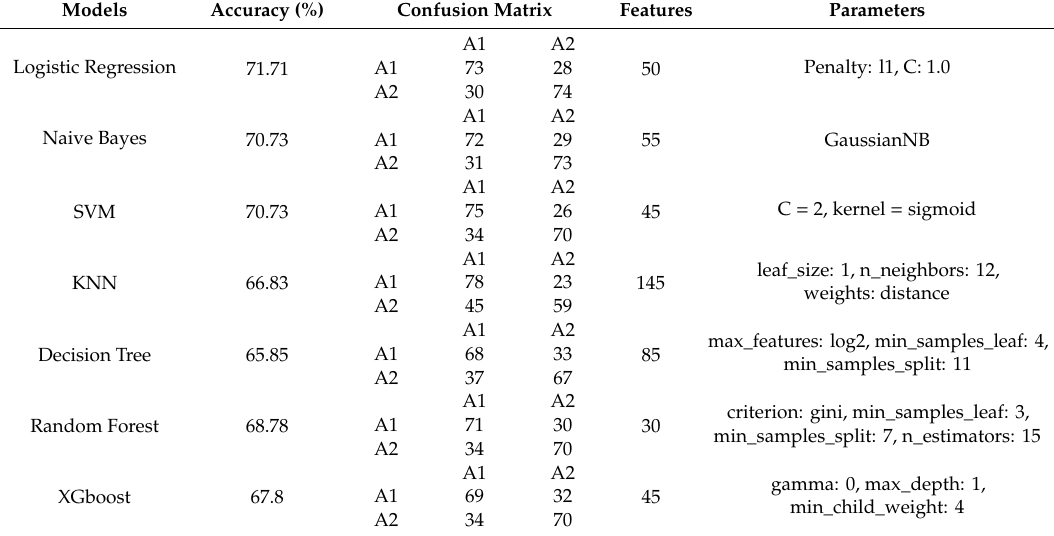
Table 4. Best testing accuracies achieved for ML model along with the confusion matrix, the optimum number of features and the hyperparameters of the ML models employed. A1 and A2 denote classes 1 and 2 of dataset A, respectively.